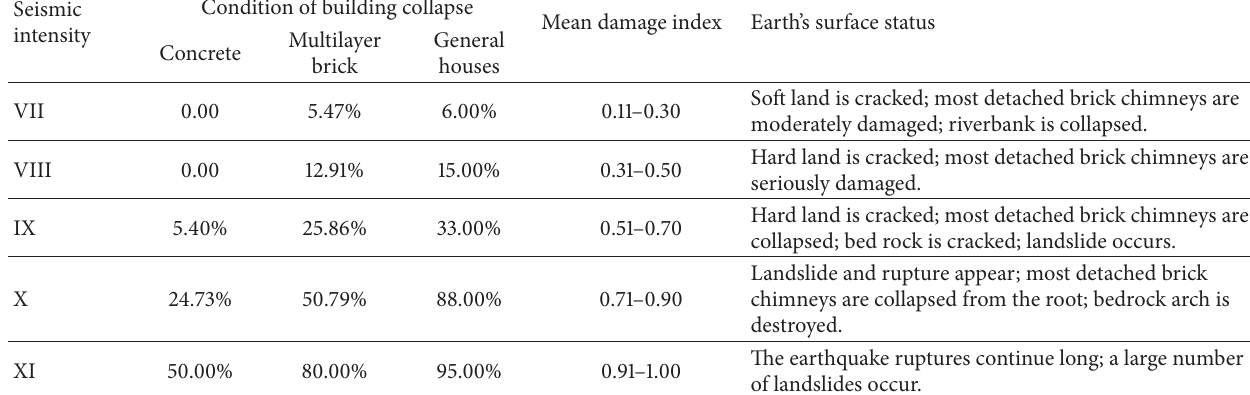
Table 1: Standard of seismic intensity division.